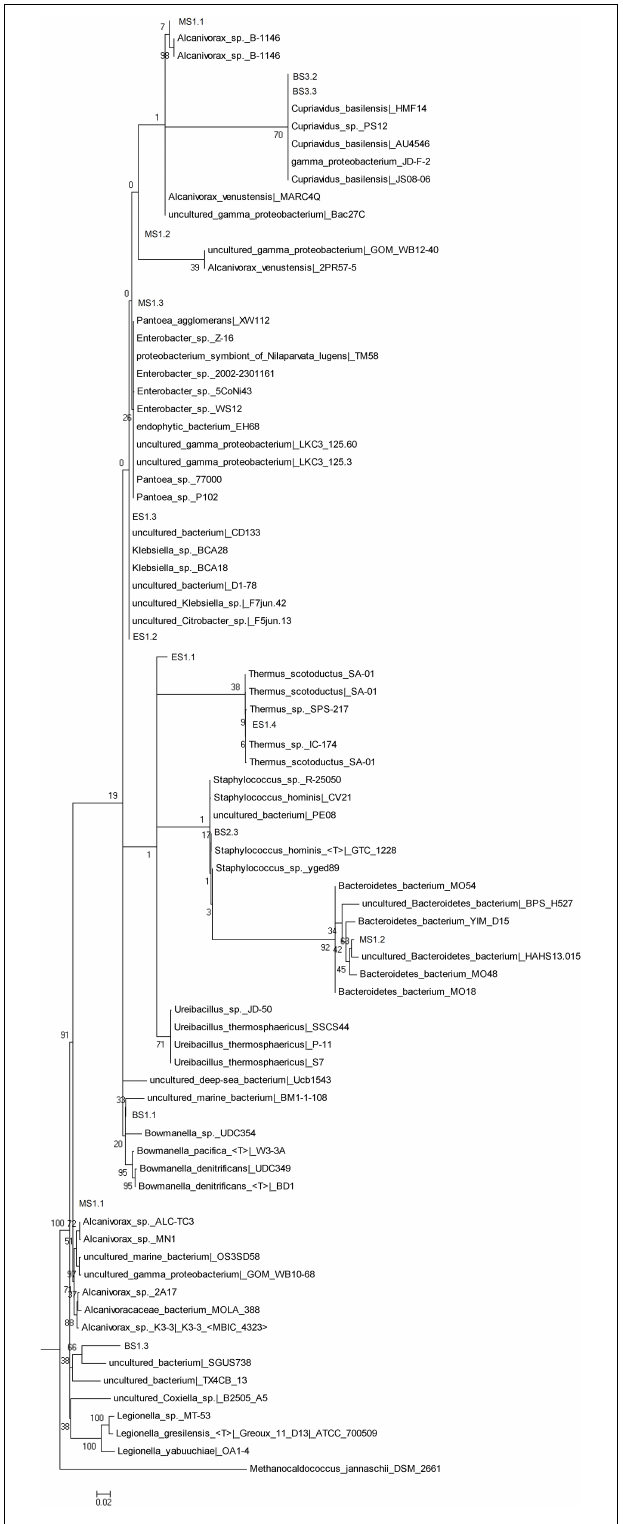
FIGURE 2 | Phylogenetic tree of the Bacteria extracted from the salt stalactites.